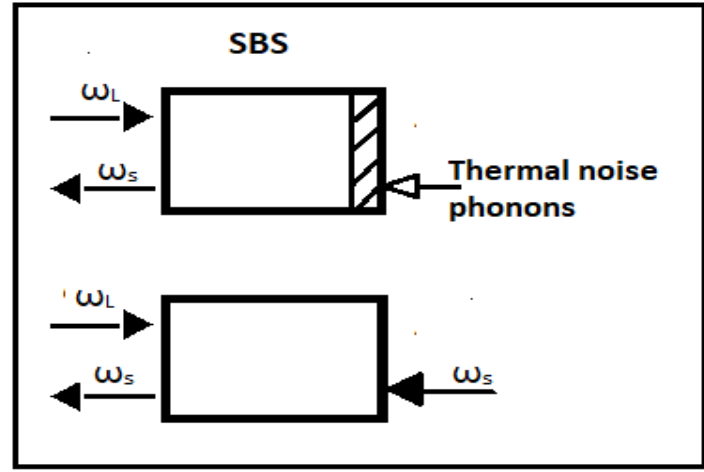
Figure 6. SBS generator on the top and SRS amplifier on the bottom.